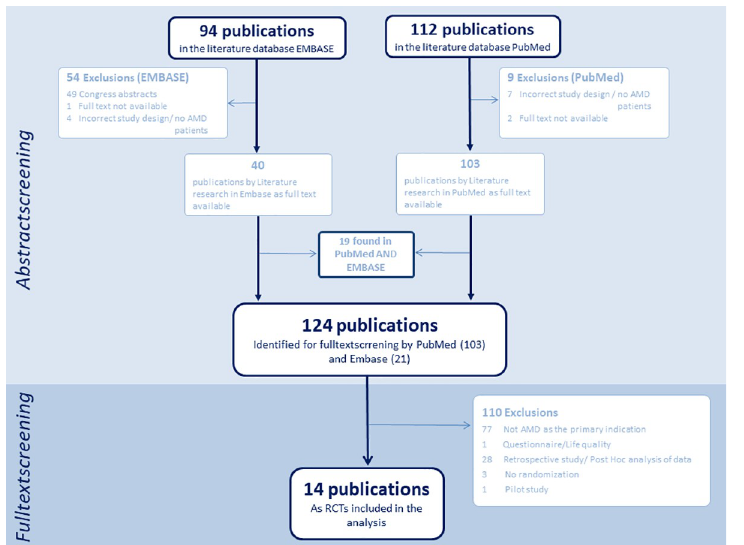
Fig 1. AMD flow chart. Flow chart on screening for publications of trials on AMD